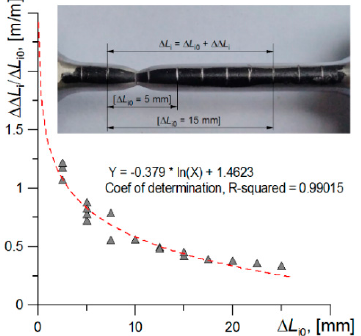
Figure 6. The scheme presents the measurement of strain in a uniaxial tensile test of the specimen (in the photo) and the obtained strain values together with the fitting function.